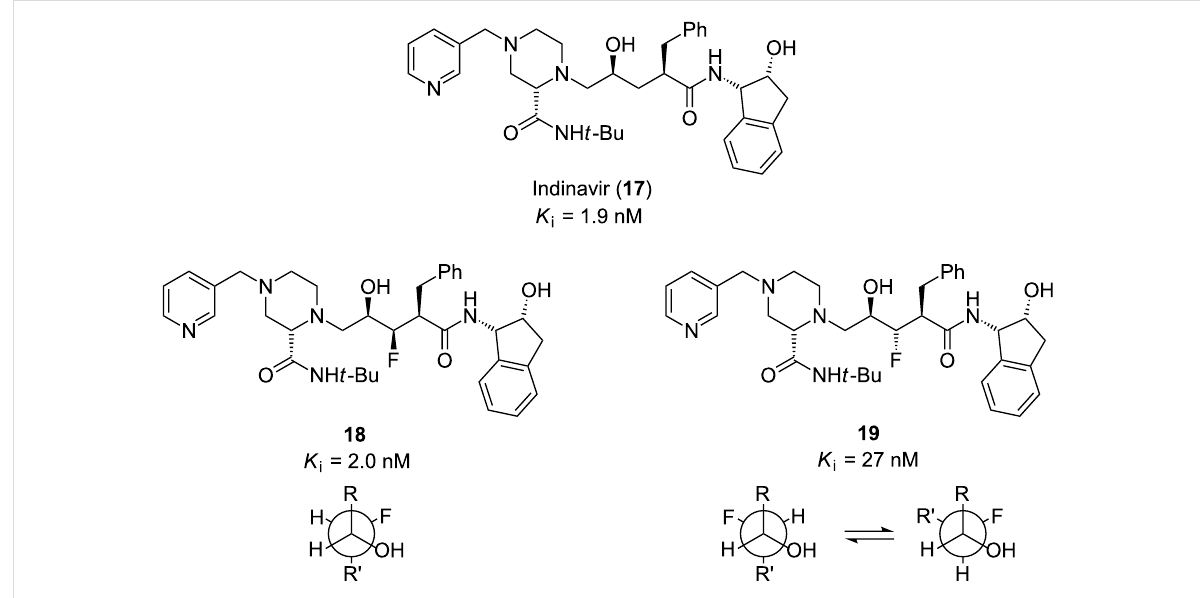
Figure 2: HIV protease inhibitor Indinavir ( 17 ) and fluorinated analogues 18 and 19 . In analogue 18 the gauche effect reinforces the active zigzag conformation, whereas in analogue 19 the gauche effect competes against the zigzag conformation resulting in conformational disorder.